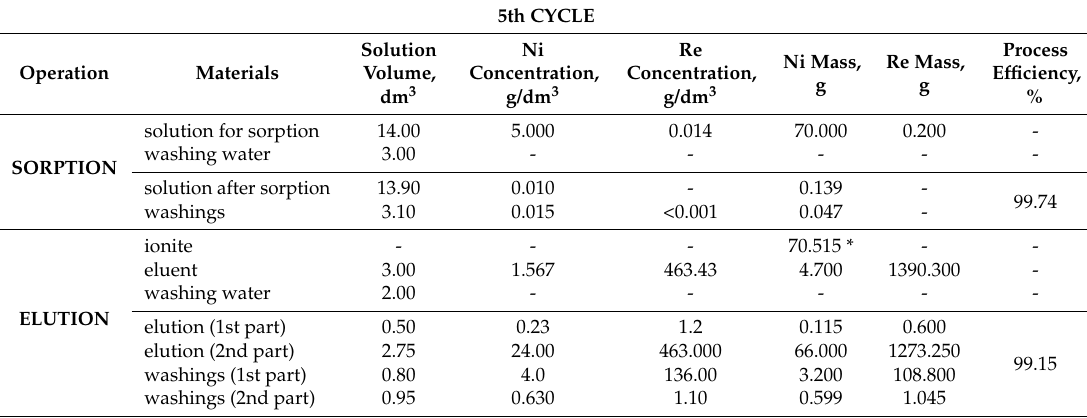
Table 19. Balance for nickel(II) sorption and elution—5th cycle. 5th CYCLE